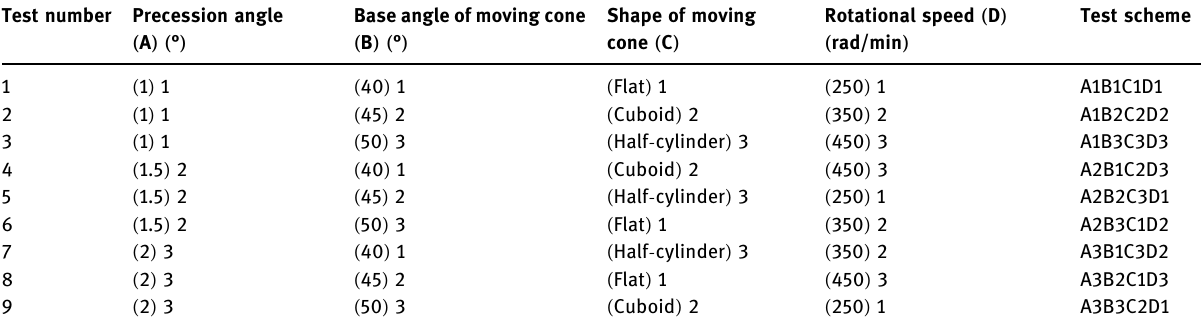
Test number Precession angle ( A ) ( ° )